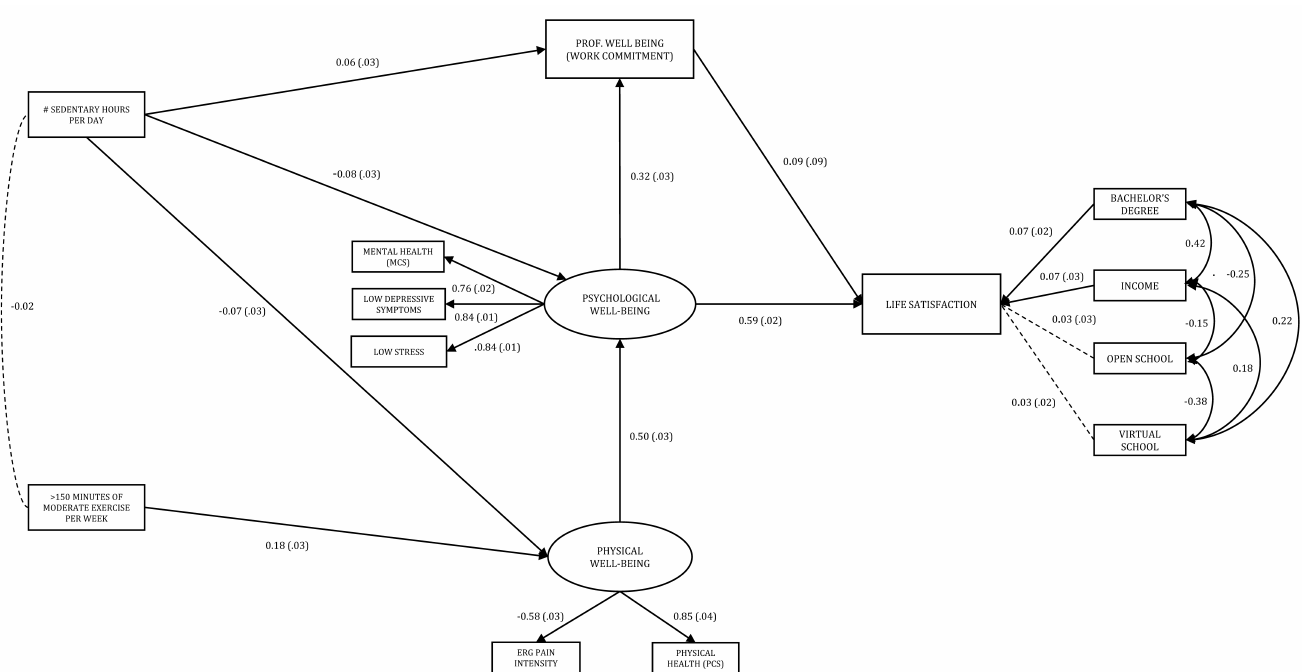
Figure 3. Empirical Test of Well-Being Mediation Model. Note. Bootstrapped standardized estimates and standard errors reported (resampling size = 1000), standard errors in parentheses. The regression weights for PCS and low stress were constrained to 1 for analysis. All paths significant p < 0.01 except sedentary hours per day to professional well-being, p < 0.05. Dotted paths/covariances non-significant. Fit statistics: χ 2 = 188.53, df = 54, p < 0.001, TLI = 0.946, CFI = 0.963, and RMSEA = 0.045, 90% CI [0.038–0.052], pclose =